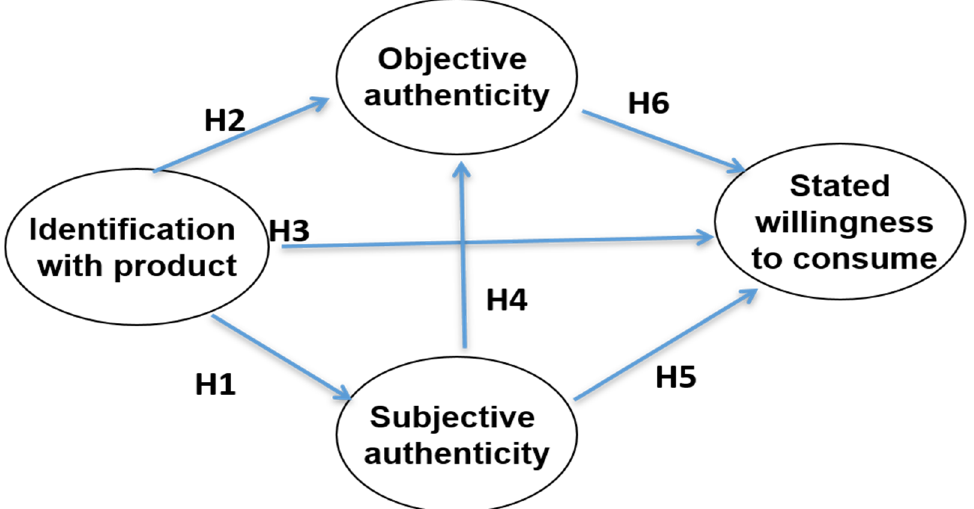
Figure 1. Research hypotheses.